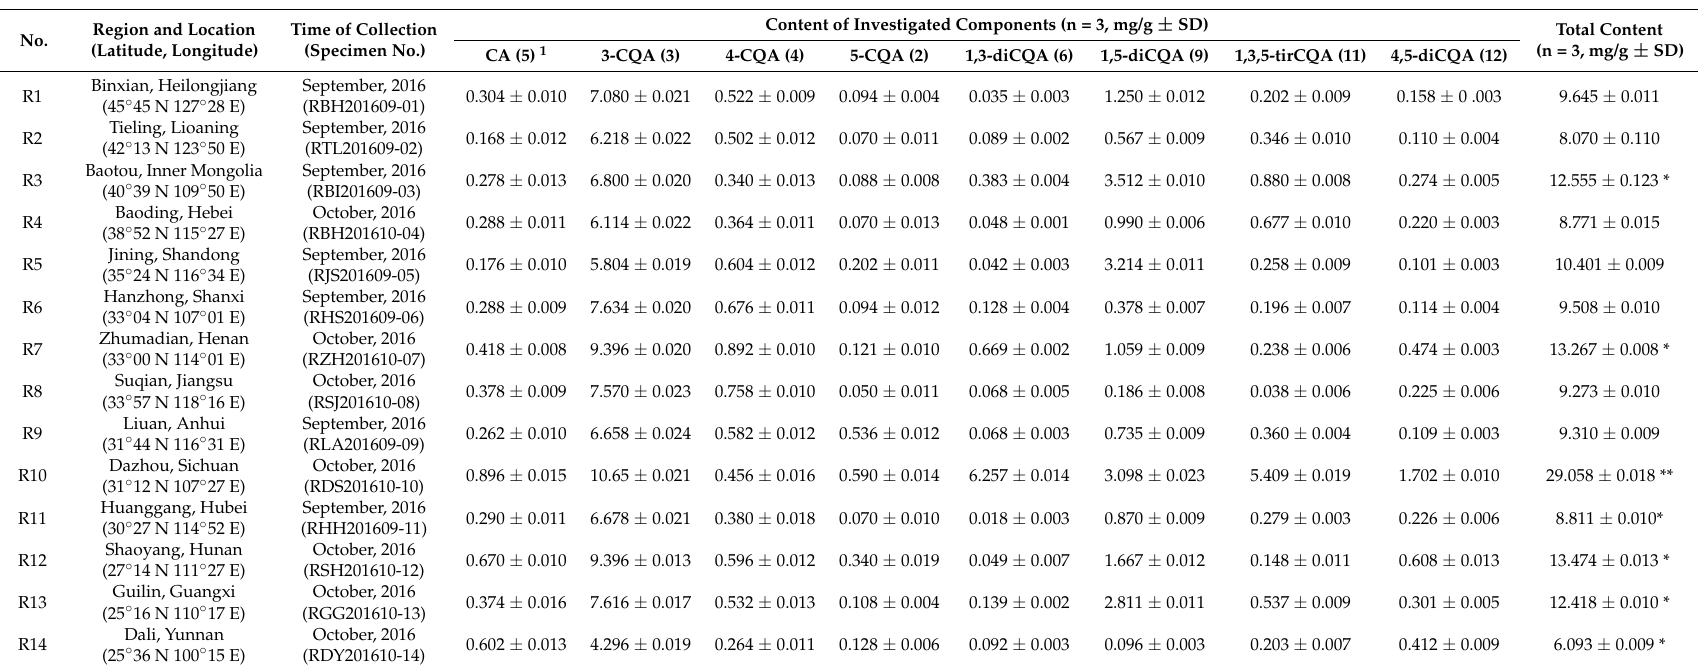
1 Corresponds to the peak number in Figure 2. Compared with R9 group, * p < 0.05, ** p <